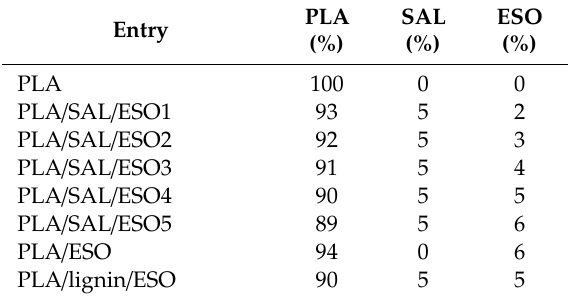
Table 1. Composition of PLA, succinylated lignin (SAL), and epoxidized soybean oil